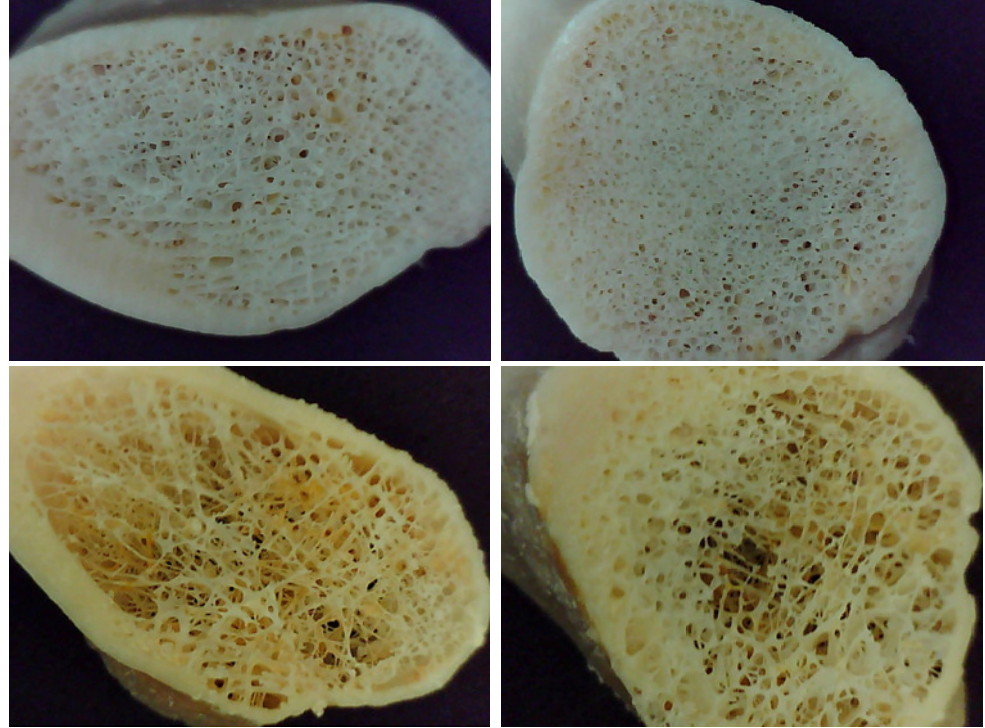
Figure 1. Proximal ( left ) and distal ( right ) cross-sections of femur neck. Top row correspond to 25 years-old male donor, while bottom are from 68 years-old